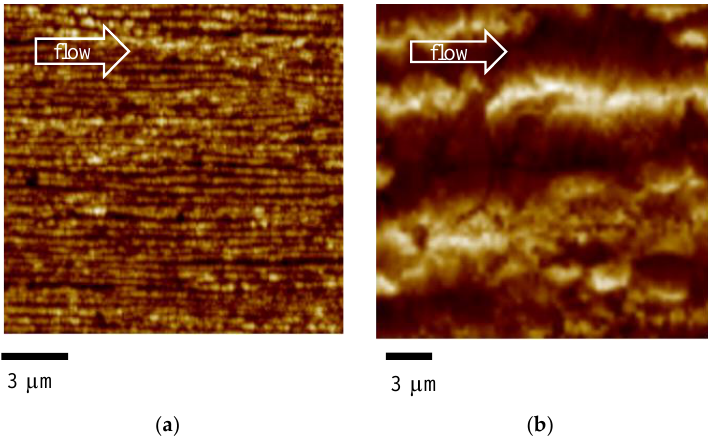
Figure 5. Magnification of the AFM height map at ( a ) 0.25 mm and ( b ) 0.50 distance from the sample surface for 80-07 sample.